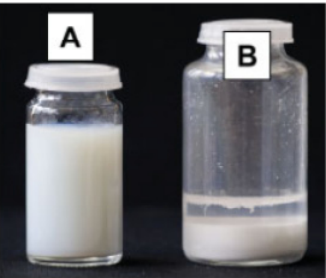
Figure 1. Comparison of latex stability (1 day after polymerization). Latex A : 6 wt % xanthate-functionalized dextran. Latex B : 6 wt % native dextran. Reproduced with permission from reference